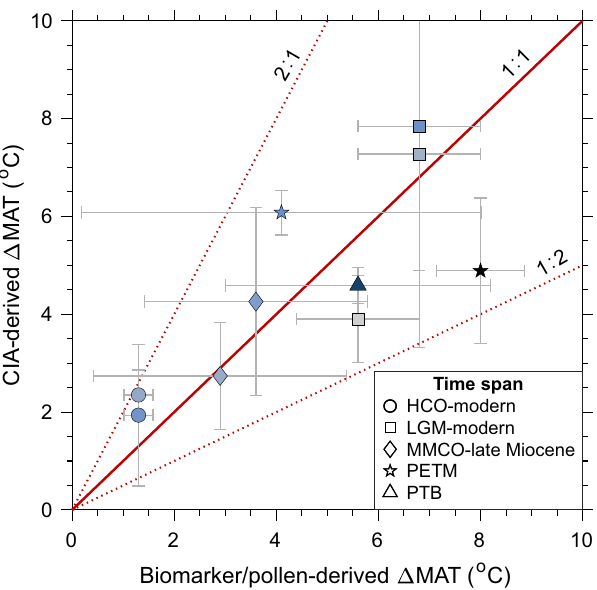
Fig. 5 Reconstruction of regional paleo-temperature changes ( Δ MAT) for selected climatic events. The comparison between two methods, that are, MAT – CIA relation (this study) and biomarker or pollen records (from literature) are shown here. The events include Holocene Climatic Optimum (HCO), Last Glacial Maximum (LGM), Middle Miocene Climate Optimum (MMCO), Paleocene – Eocene thermal maximum (PETM), and Permian – Triassic boundary (PTB). The symbol color indicates the sampling latitude of sedimentary CIA records: a darker color corresponds to a higher latitude (range: 8 – 78°). The error bars represent one standard deviation. The relative uncertainty of Δ MAT estimated from paleo-CIA records could even be lower compared to the other method especially in pre-Quaternary events. We note that terrestrial paleo-temperature reconstructed by biomarker/pollen records are scarce and rarely measured at the same location as sediment CIA. Hence, we tried to fi nd synchronous biomarker/ pollen records at a latitude similar to the sediment source region. Distributions of Δ MAT derived from both methods are indistinguishable based on a paired t -test ( p > 0.05). Detailed information including references on sediment cores and paleo-temperature records is provided in Supplementary Data